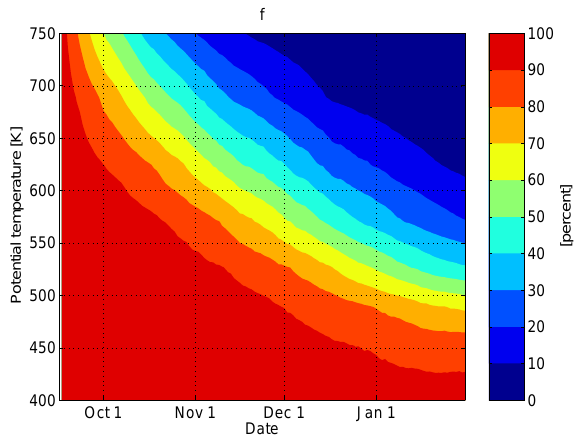
Fig. 2. Surviving fraction of an artificial ozone perturbation on 16 September 1999 according to Eq. (1) as a function of poten- tial temperature and time, averaged over equivalent latitudes greater than 65°N.